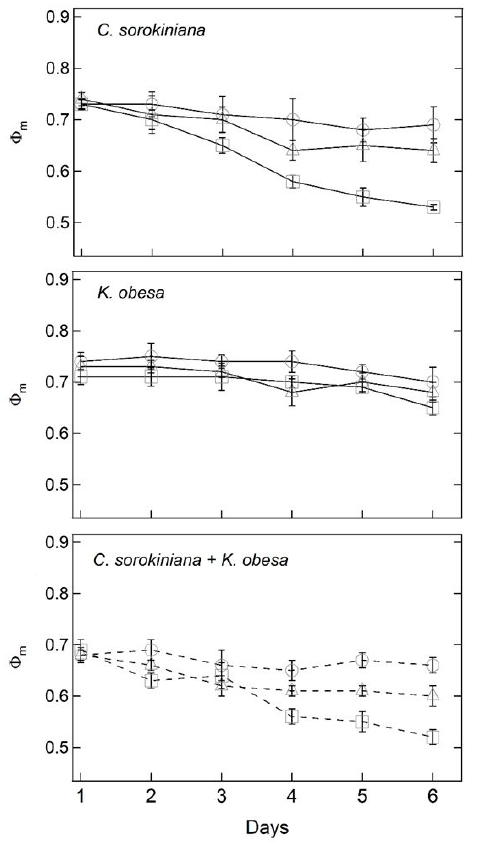
Figure 6. Maximum photosynthetic yield ( Φ ) of Chlorella m sorokiniana (up), Kirchneriella obesa (middle) and co- cultivation (down) as a function of experimental period in days with mean ± standard deviation. Copper concentration symbols: ○ (control, 6x10 -9 mol L -1 ), (intermediate, 2x10 -7 mol L -1 ) and □ (high, 1.5x10 -6 mol L -1 △